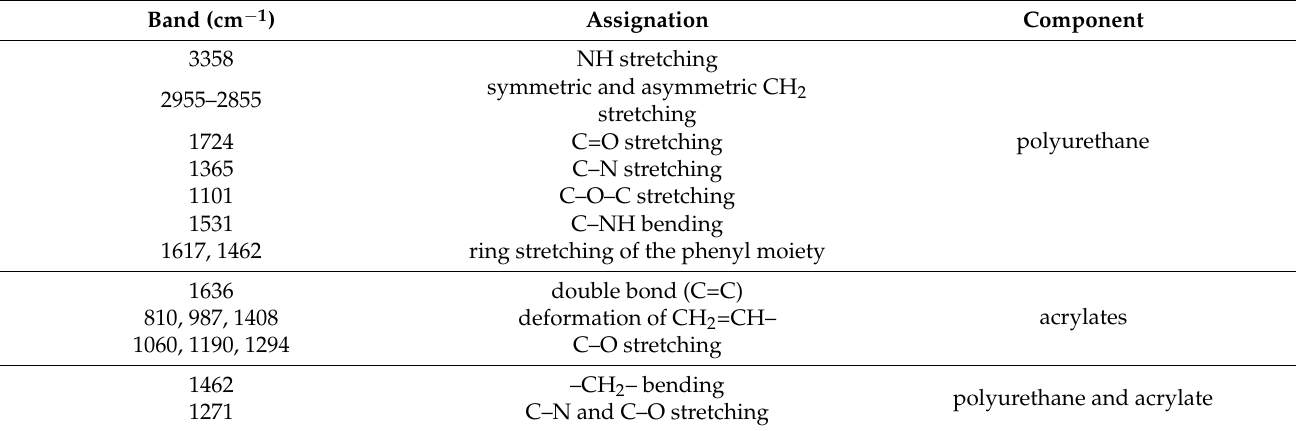
Table 3. Vibrational bands of UV curable TC print and their assignations [47–53].